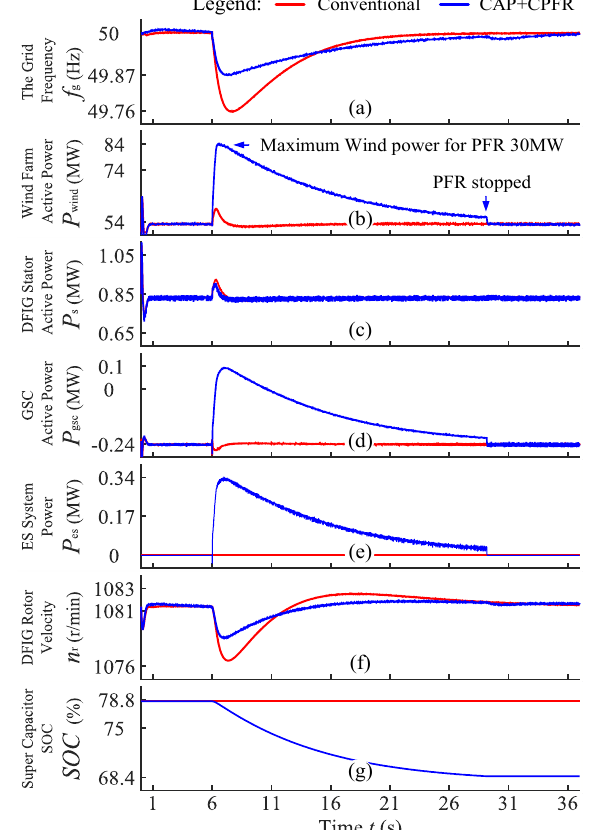
Figure 14. Frequency regulated operation waveforms of a wind farm at a low wind speed: ( a ) The grid frequency; ( b ) The wind farm power; ( c – g ) The stator power, GSC power, generator unit power, ESS power, rotor velocity and ESS SOC of the DFIG-VSG system.